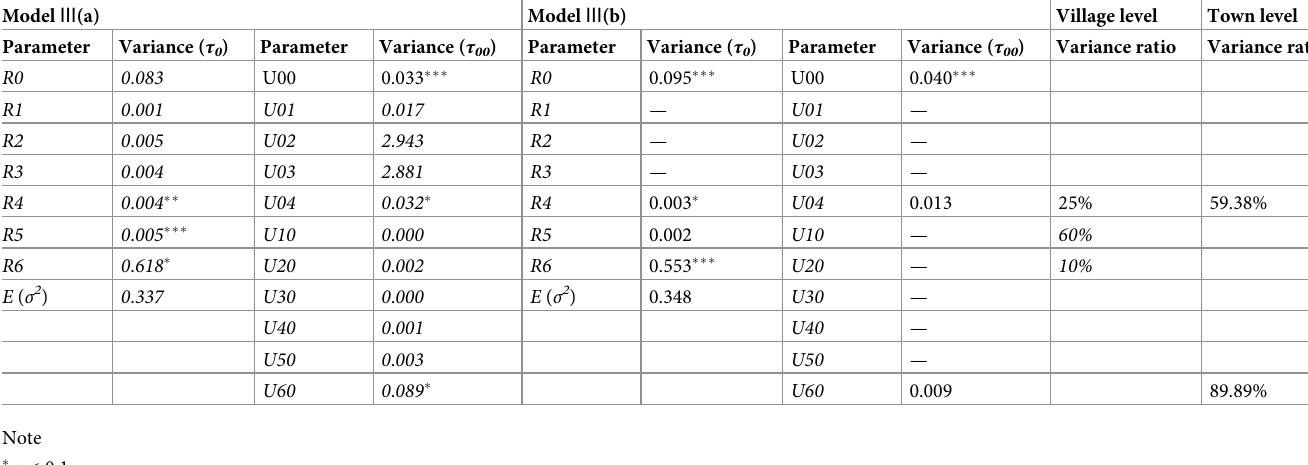
Table 8. The comparison of random effects of Model III (a) and Model III